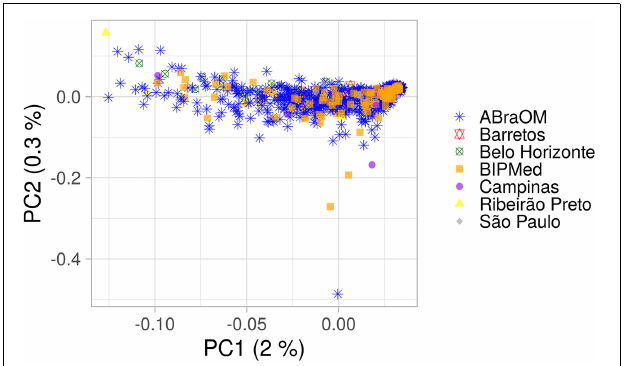
FIGURE 1 | PCA plot of the BRS sample. The x -axis and y -axis show the first and second principal components (PC1 and PC2) and their respective percentage variability. Each point represents one individual, and each shape and color indicate a birthplace or database. Only information from individuals with a known place of birth was